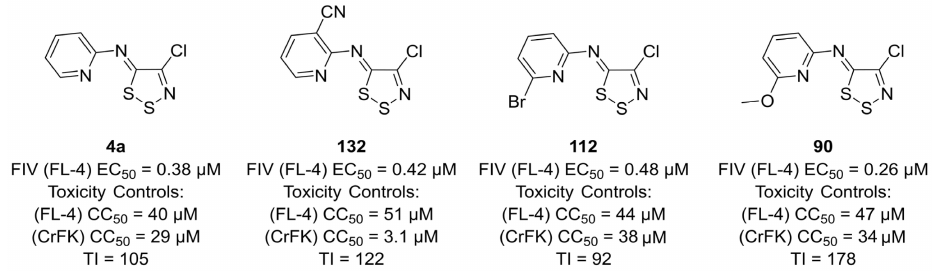
Figure 26. 2-Pyridyl substituted 1,2,3-dithiazoles active against FIV.